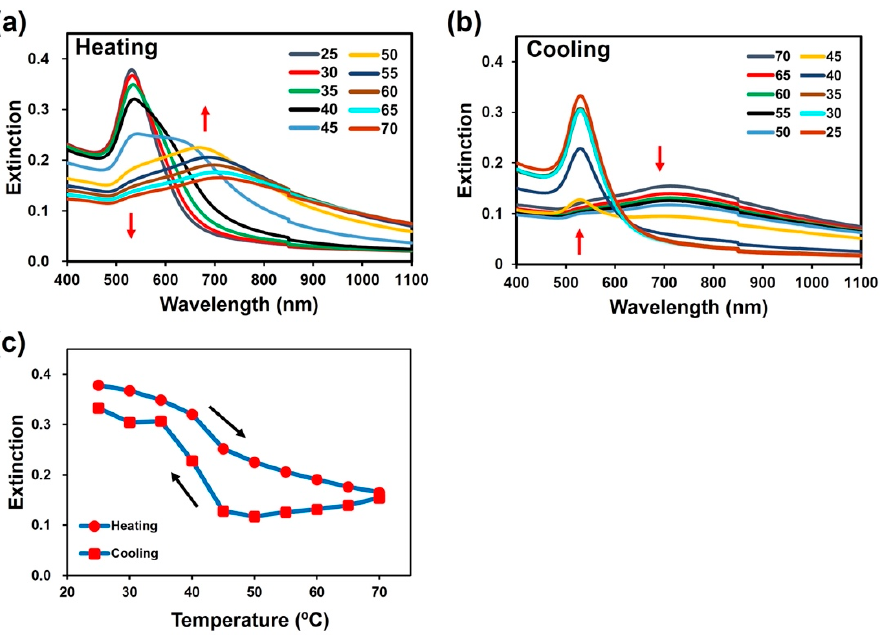
Figure 4. Thermo-responsive assembly of 40-AuNS-(100:0): ( a ) the extinction spectra of 40-AuNS- (100:0) upon heating from 25 to 70 ◦ C and ( b ) upon cooling from 70 to 25 ◦ C; ( c ) the extinction values at 530 nm against temperature changes. The red arrows in ( a , b ) indicate the plasmon peak